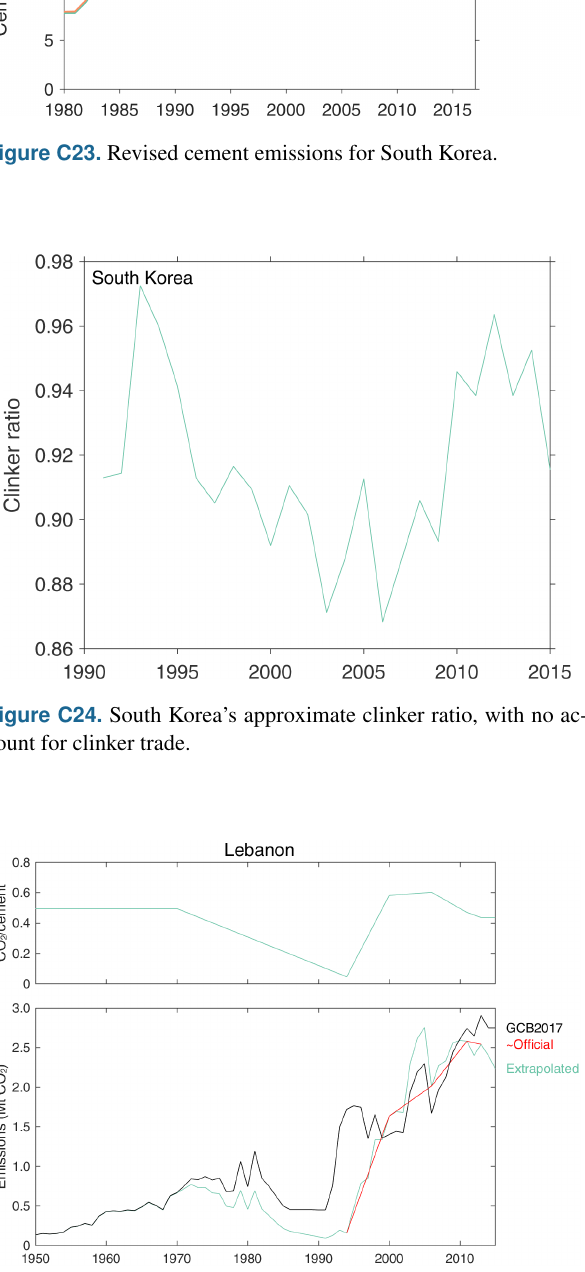
Figure C25. Revised cement emissions in